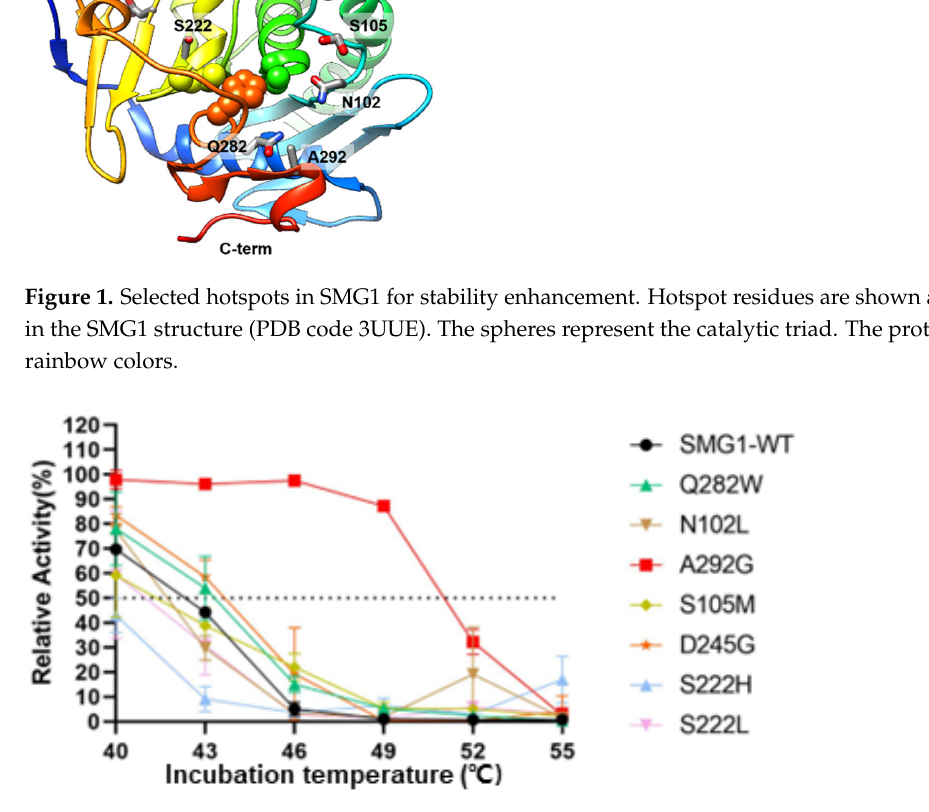
Figure 2. Thermostability test using crude lysates of the WT and selected mutants. Crude lysates of the SMG1 WT and mutants were incubated at various temperatures between 40–55 ◦ C at pH 7.0 in a 20 mM sodium phosphate buffer for 15 min and assayed for their residual activity at 24 ◦ C. The enzymatic activity of each construct without the heat treatment was treated as 100%. The sample was kept on ice and pre-equilibrated to the reaction temperature before the reaction was conducted at 24 ◦ C. Each data point represents an averaged result of three independent experiments with triplicates. The error bar indicates the standard error of three independent experiments. The dashed line designates a residual activity of